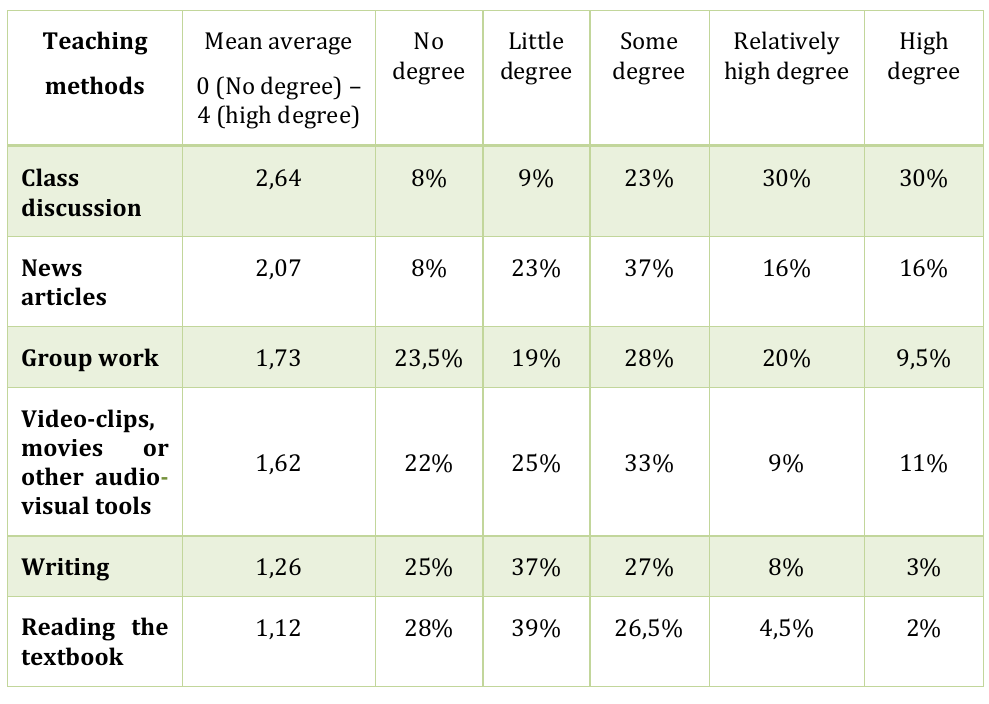
Table 2: Perceptions of teaching methods based on data collected by the author in